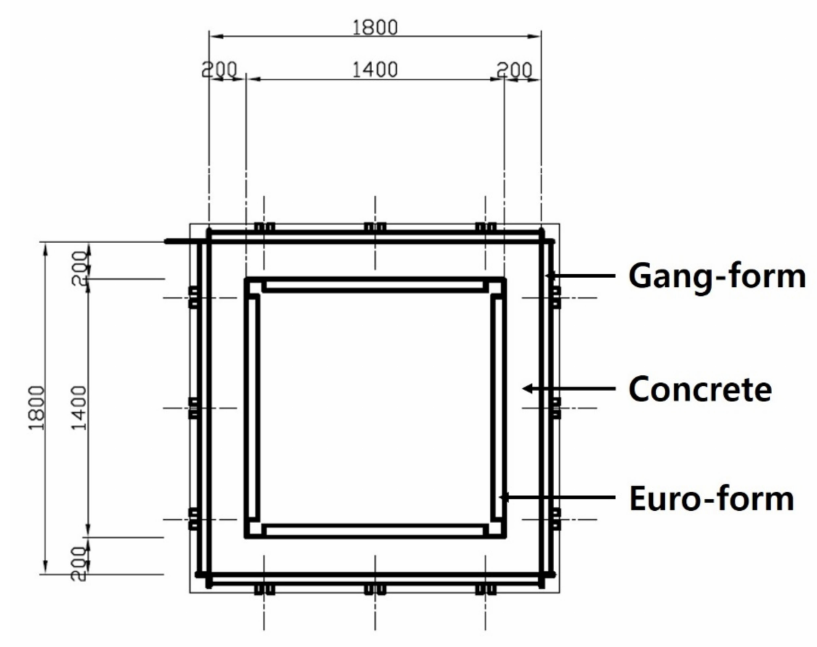
Figure 3. Sketch of the floor plan.